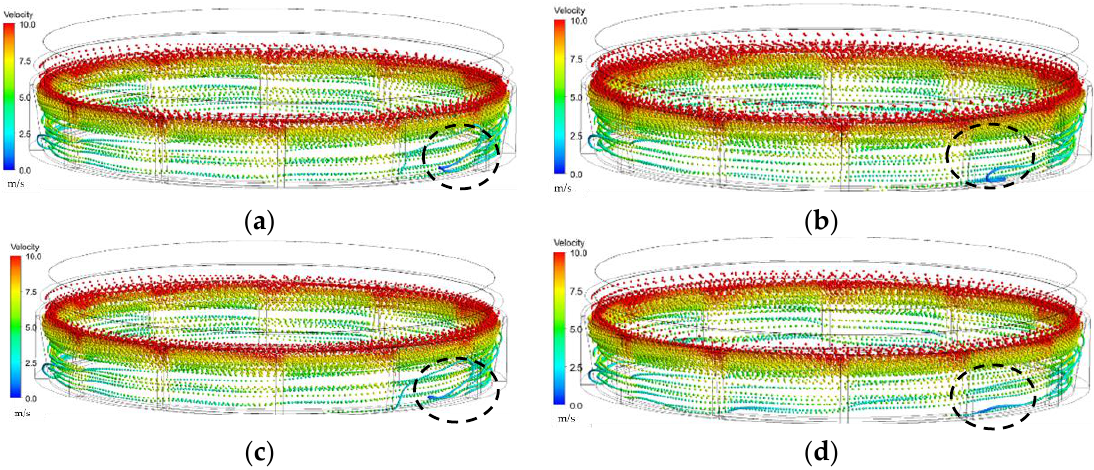
Figure 9. Particle trajectory in the band under different guide vane opening. ( a ) 10 ◦ , ( b ) 20 ◦ , ( c ) 25 ◦ , ( d ) 30 ◦ .